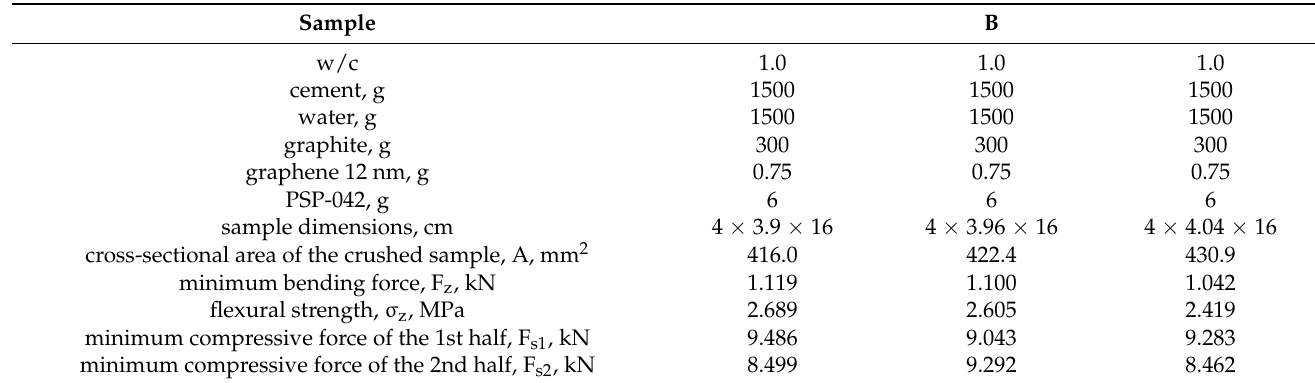
Table 3. Strength test results of the hardened sealing slurries: sample